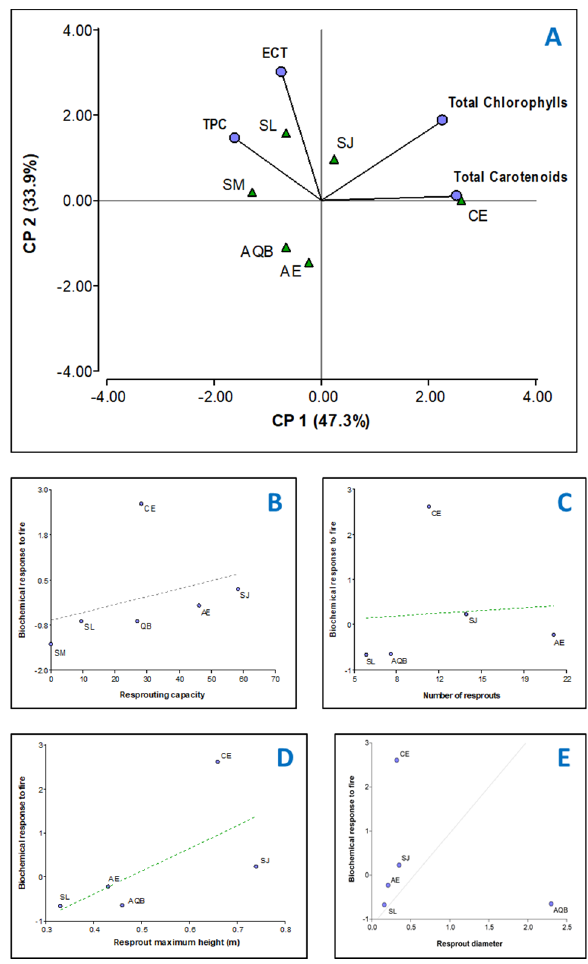
Figure 4. ( A ) Principal component analysis (PCA) of the plant biochemical response to fire. The ordination was based on the total contents of chlorophylls, carotenoids, total phenolic compounds (TPC), and extractable condensed tannins (ECT) from burnt plants in EB 2016. ( B ) Correlation between the resprouting capacity (RC), ( C ) the number of resprouts, ( D ) the resprouts maximum height, and ( E ) the resprouts diameter with the first component of the plant biochemical response to fire. The green line shows where the points would have a perfect correlation between RC and biochemical response to fire. Species below the line had a higher content of bioactive compounds in relation to RC, while species above the line had a higher response to fire compared to the content of bioactive compounds biosynthesized (Pearson’s p = 0.60, p -value < 0.0001). References: SM = S. mistol , SJ = S. johnstonii , SL = S. lorentzii , AE = A. emarginata , AQB = A. quebracho-blanco , CE = C. ehrenbergiana